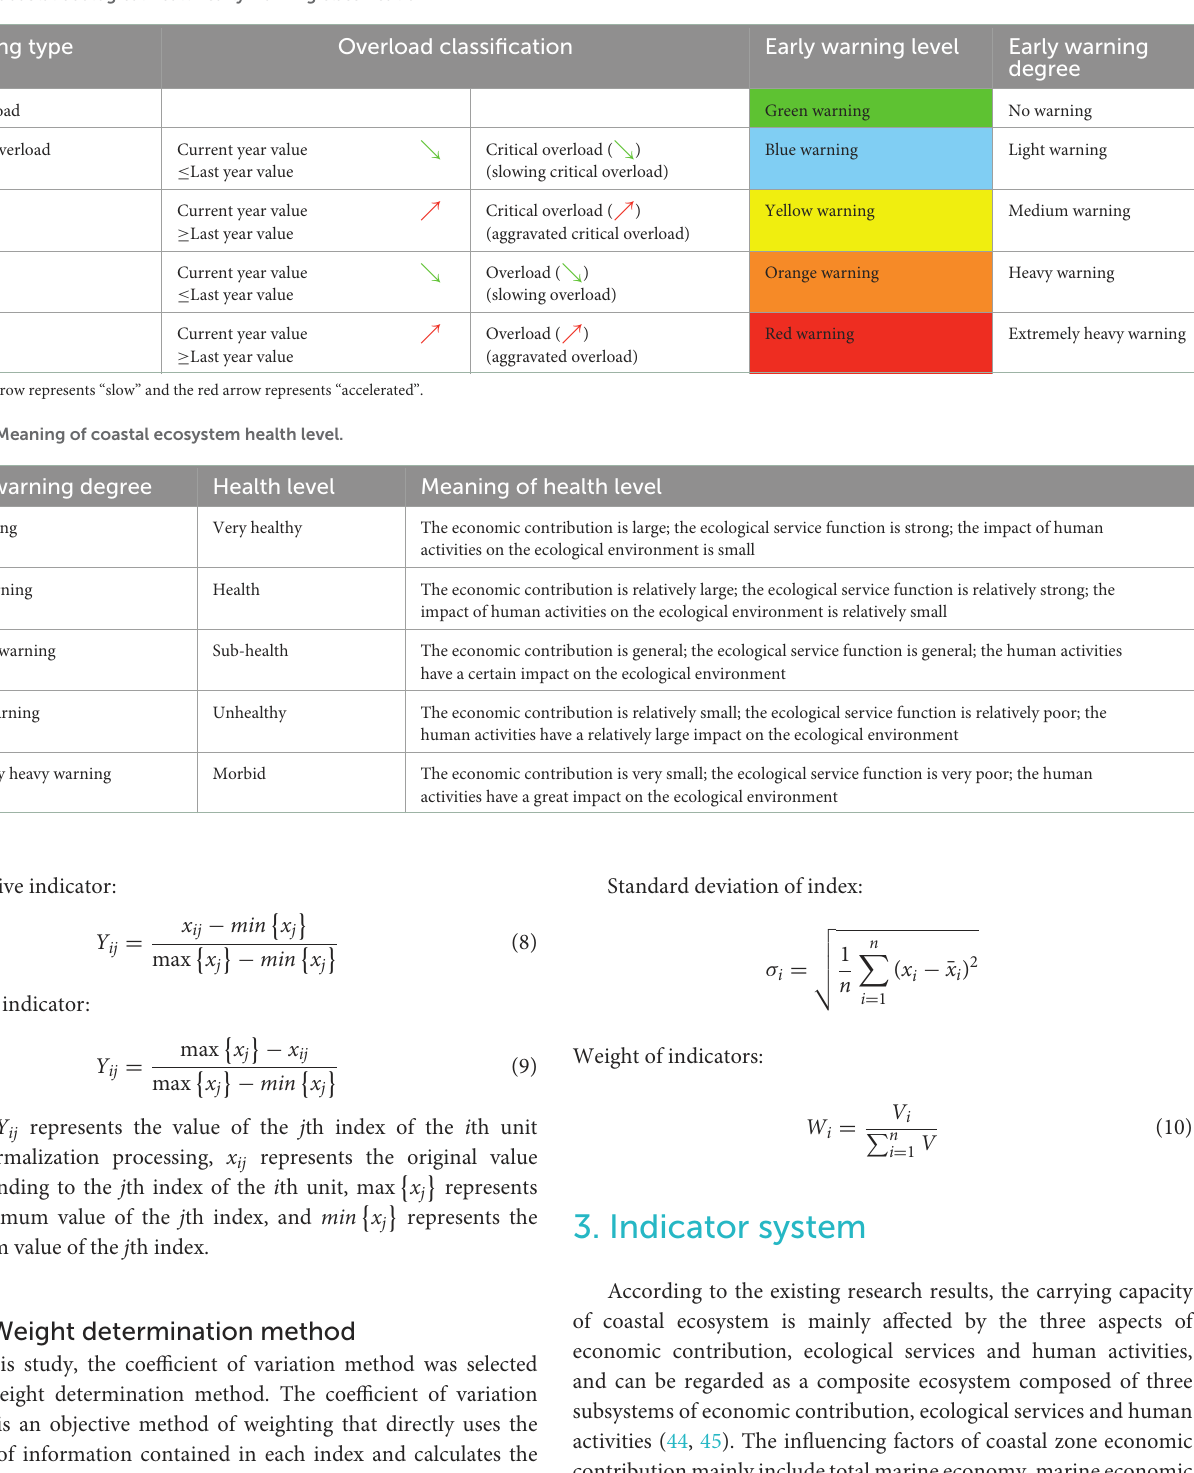
TABLE 3 Coastal ecological health early warning classification.